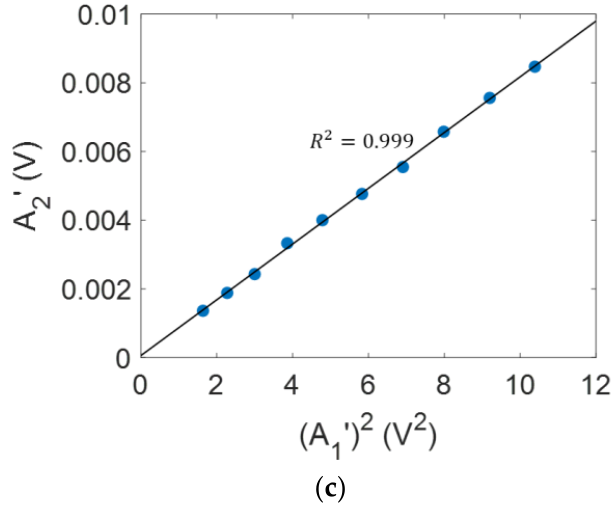
Figure 7. ( a ) Typical time-domain ultrasonic signal measured from the TT mode, ( b ) its frequency spectrum transformed using FFT, and ( c ) relationship between (𝐴 1 ′ ) 2 and 𝐴 2 ′ with the increasing voltage input to obtain parameter 𝛽′ .